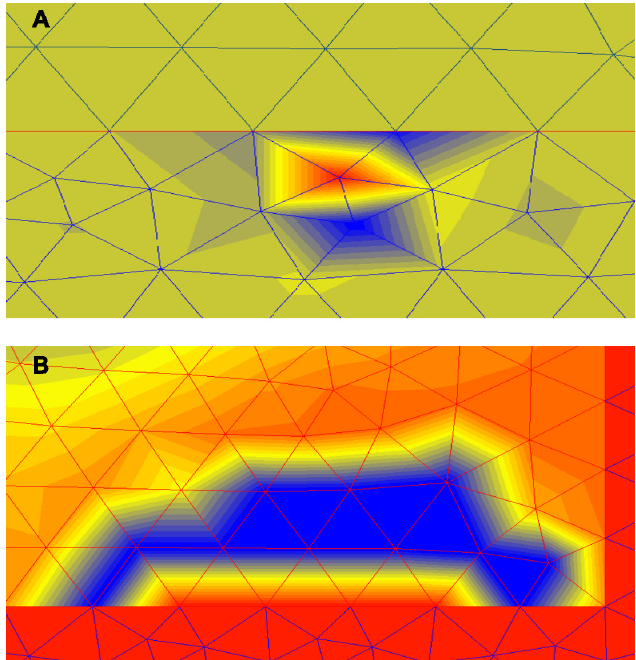
Figure 16. Erroneous results. Errors appearing in computational results for ( A ) temperature and ( B ) solid phase fraction are caused by too large the time step (e.g., in the explicit scheme or when multiplication factor m > 15). There were occurred at the interface between the mold and the cast. Contrasting colors (blue in A , and red in B ) denote incorrect values of solid phase